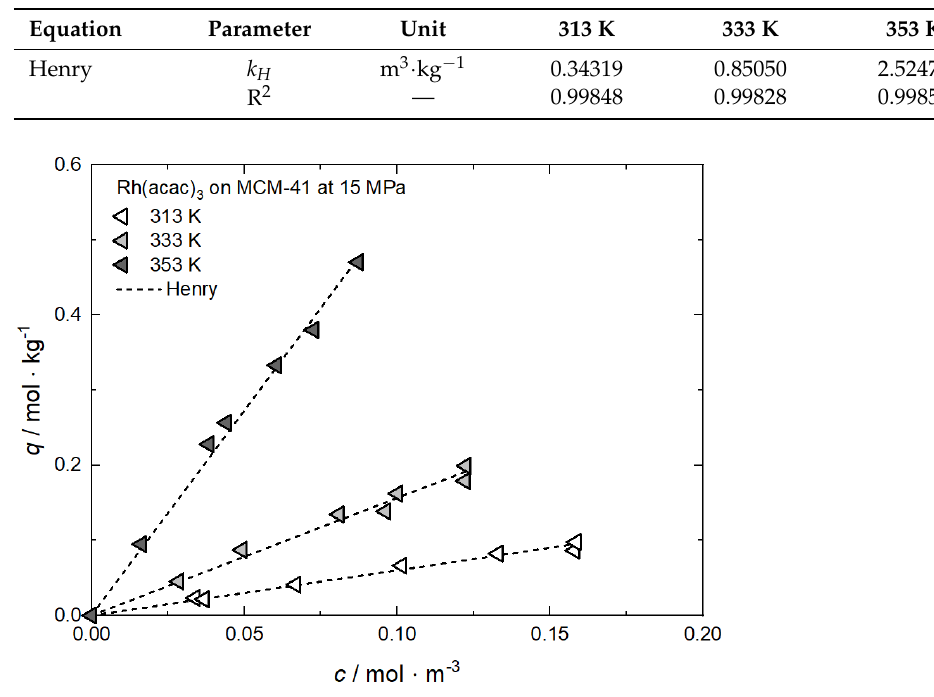
Figure A7. Uptake of Rh(acac) 3 on HMS at 15 MPa and different temperatures; experimental data taken from [62]. Table A7. Adsorption isotherm parameters for Rh(acac) 3 from scCO 2 solution on HMS at 15 MPa and different temperatures [62].